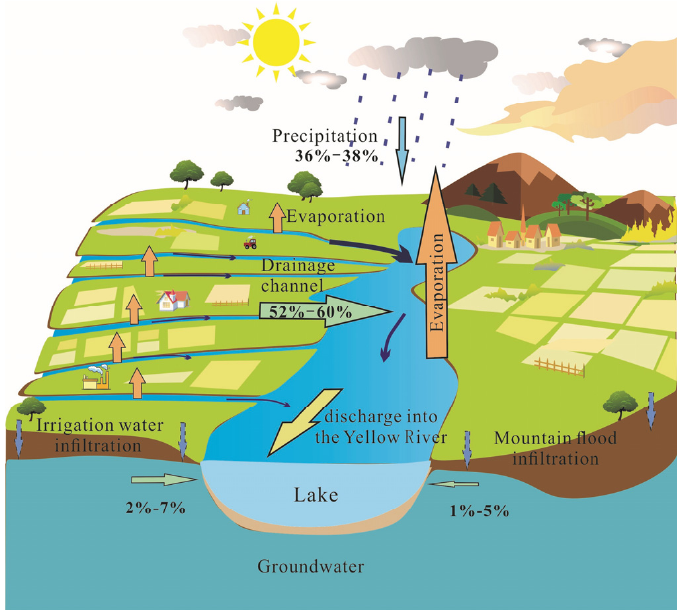
Figure 9. Model characterizing the regional hydrological cycle in the study area established using hydrochemical and isotopic analysis results.